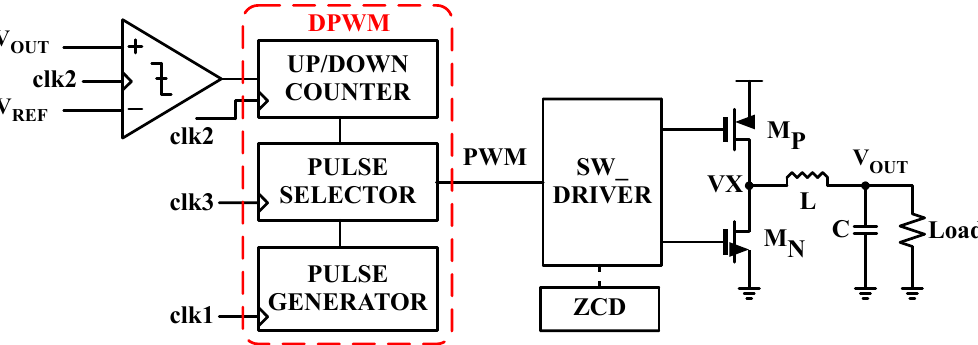
Figure 3. Structure of a DC–DC converter with the digital pulse width modulator